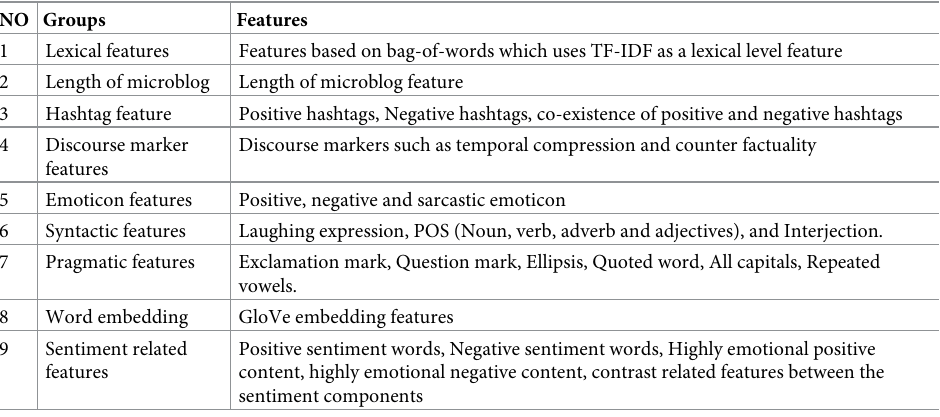
Table 4. The summary of proposed features for sarcasm